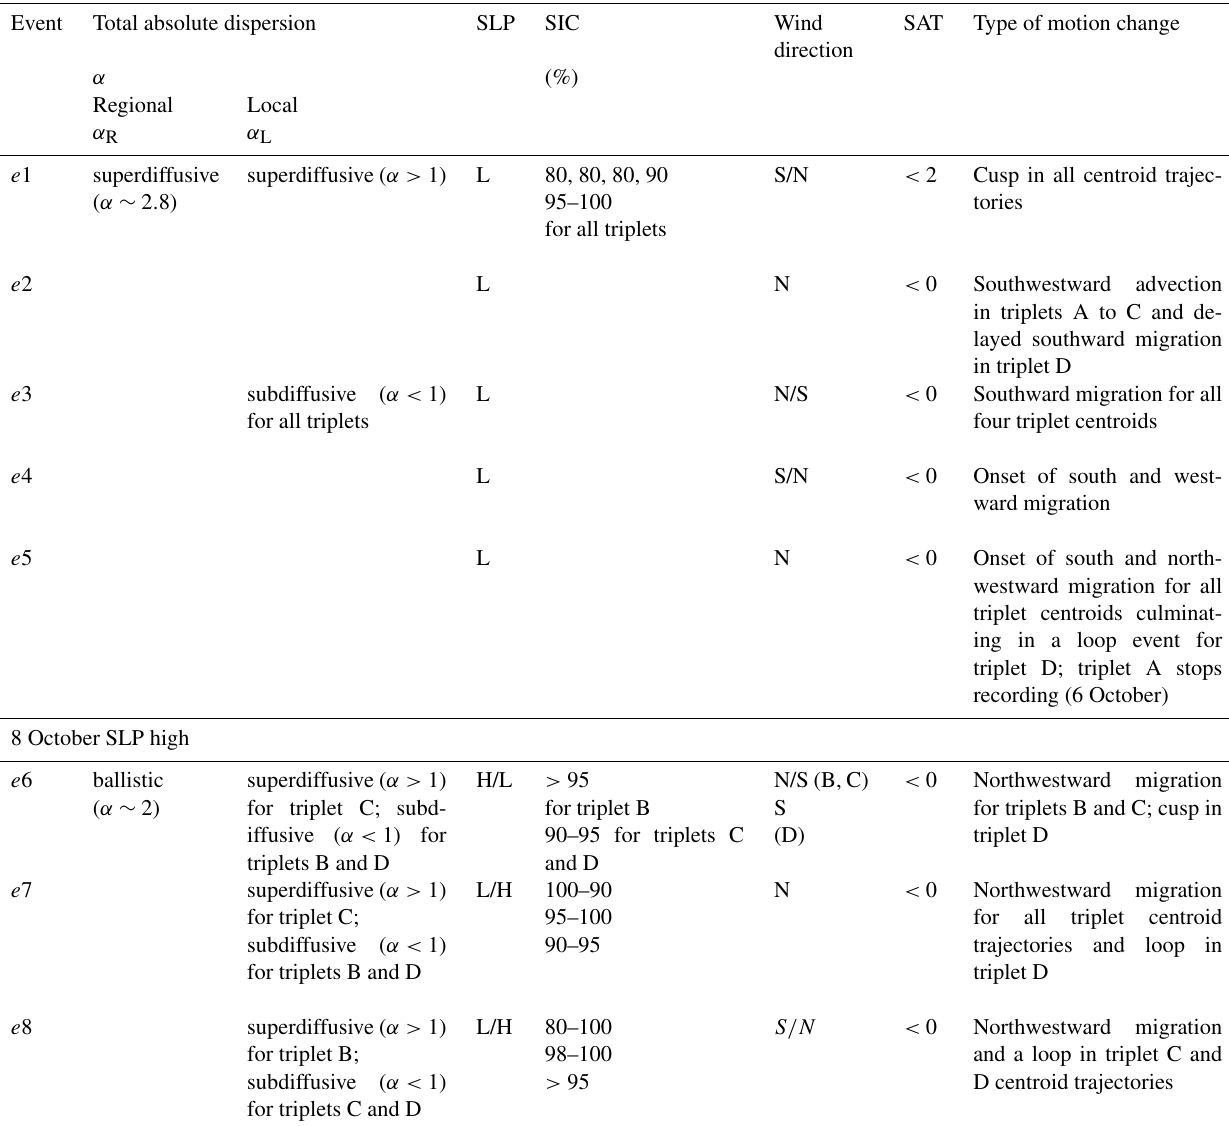
Table 1. Evolution in triplet A to D trajectories; regional and local dispersion characteristics.